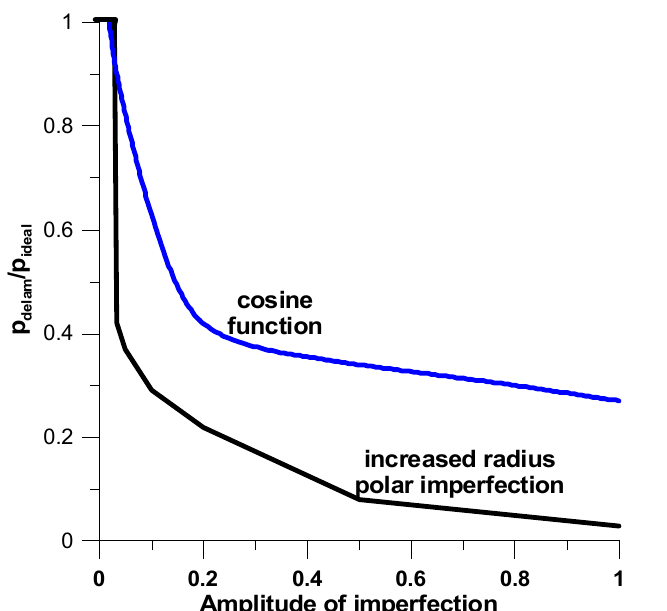
Figure 14. For cross-ply and FGMs, the values of buckling loads are almost identical due to the value of thickness ratio h/R.